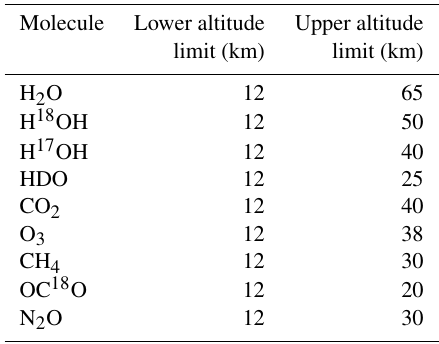
Table 2. Interferers in the v3.0/v3.5 ACE-FTS hydrogen fluoride